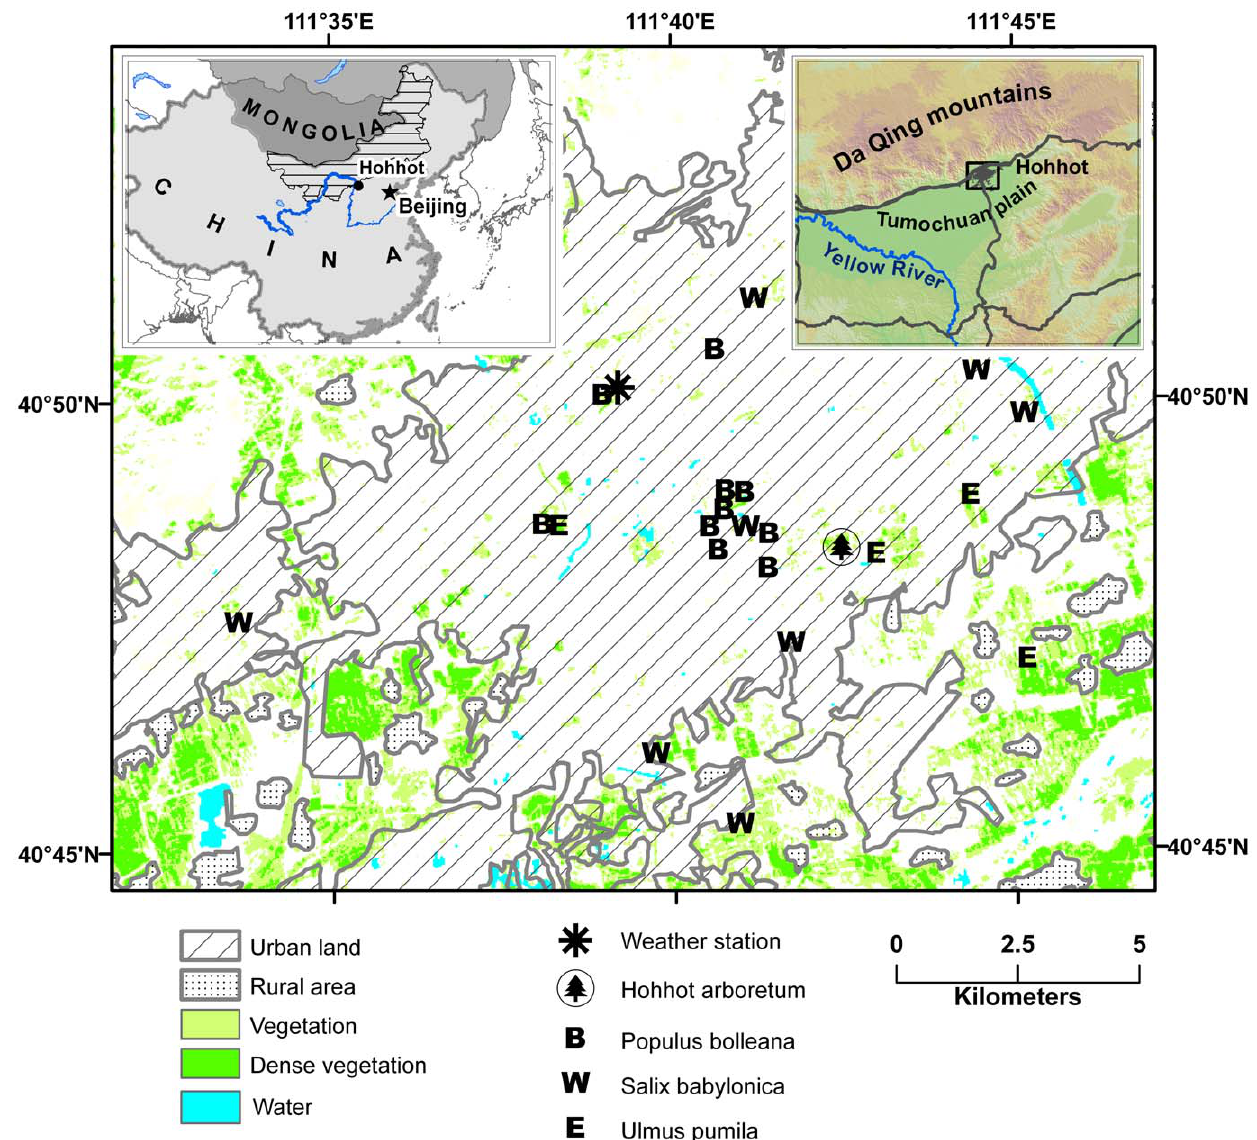
Figure 1. Map of study area showing phenology observations sites. The rectangular area in the upper right inset elevation map with major highways corresponds to the study area extent shown on the main map. Vegetation information is derived from the Normalized Difference Vegetation Index (NDVI) computed from July 28, 2010 Landsat TM image (Vegetation: NDVI=0.5–0.7, Dense vegetation: NDVI . 0.7).